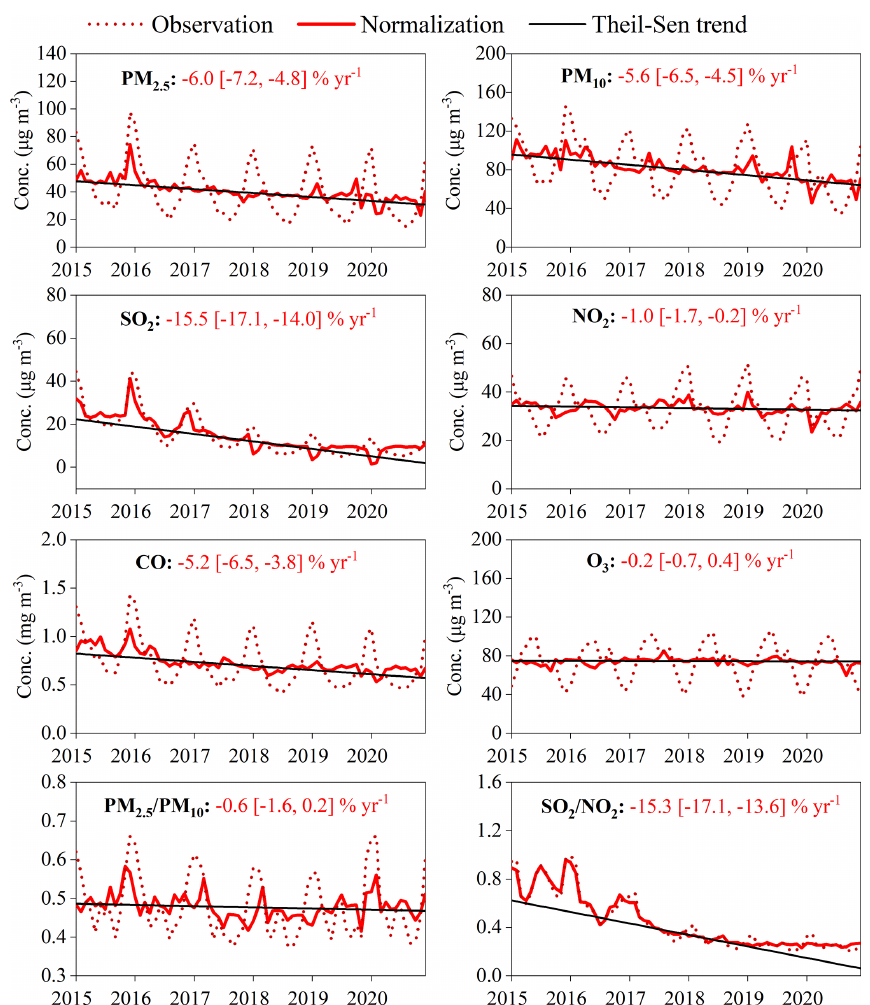
Figure 1. Trends of air pollutant concentrations and PM 2 . 5 / PM 10 and SO 2 / NO 2 from 2015 to 2020. “Observation” represents the observed data, and “normalization” represents the modelled concentrations of air pollutants after weather normalization. The black line shows the Theil–Sen trend after weather